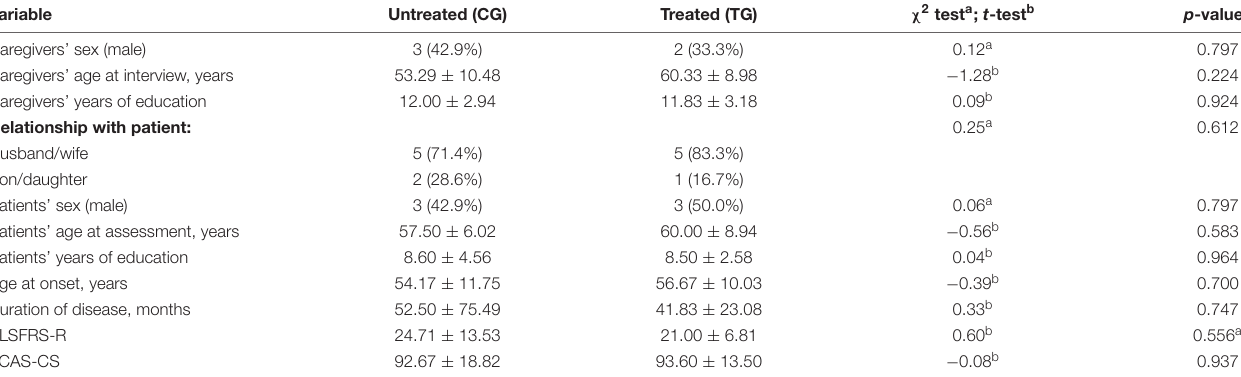
TABLE 1 | Between-group comparison at pre-treatment assessment; data are reported as mean ± standard deviation (SD) or count (percentage). Variable